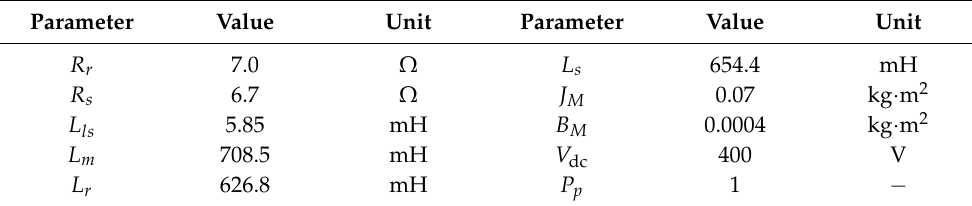
Table 1. Six-phase IM parameters.